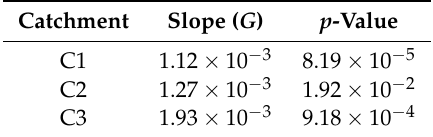
Table 4. Goodness of fit of simulated runoff at monthly